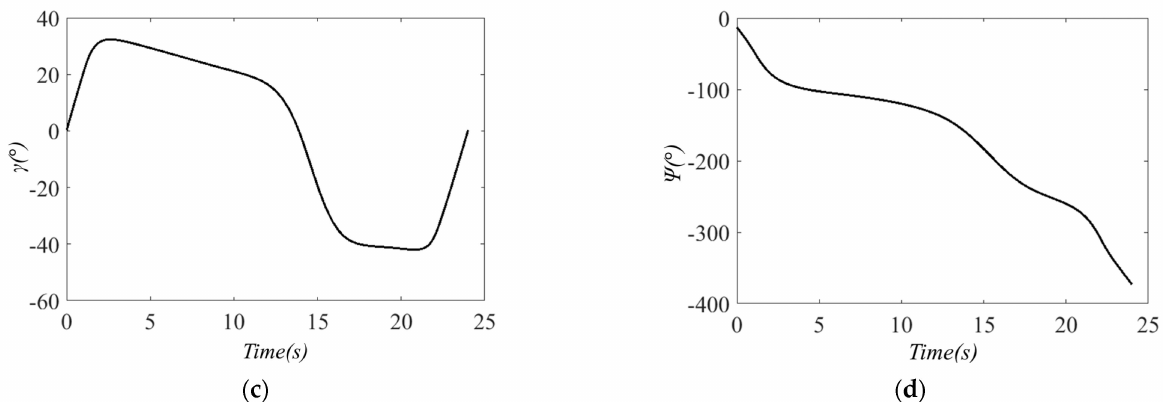
Figure 7. The optimal state trajectories in CCD of the glider dynamic soaring system: ( a ) x , y , h , ( b ) v , ( c ) γ , ( d ) Ψ .